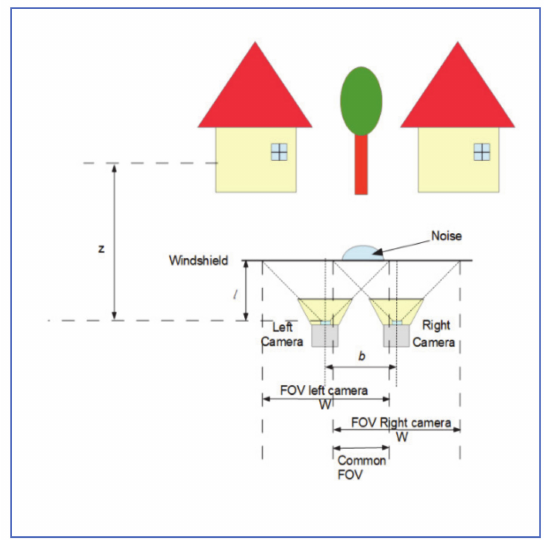
Figure 13. Attributes of a stereo camera system for adherent raindrops detection